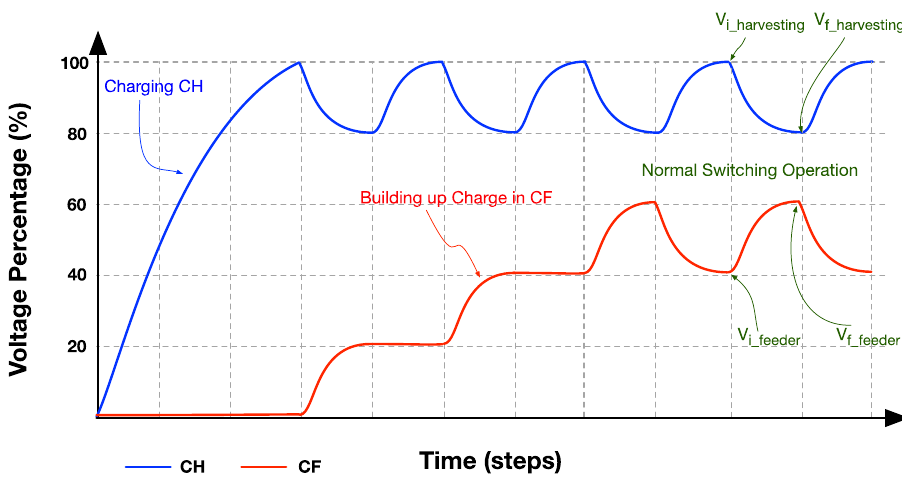
Figure 12. Time domain sequence for the operation of CH and CF .